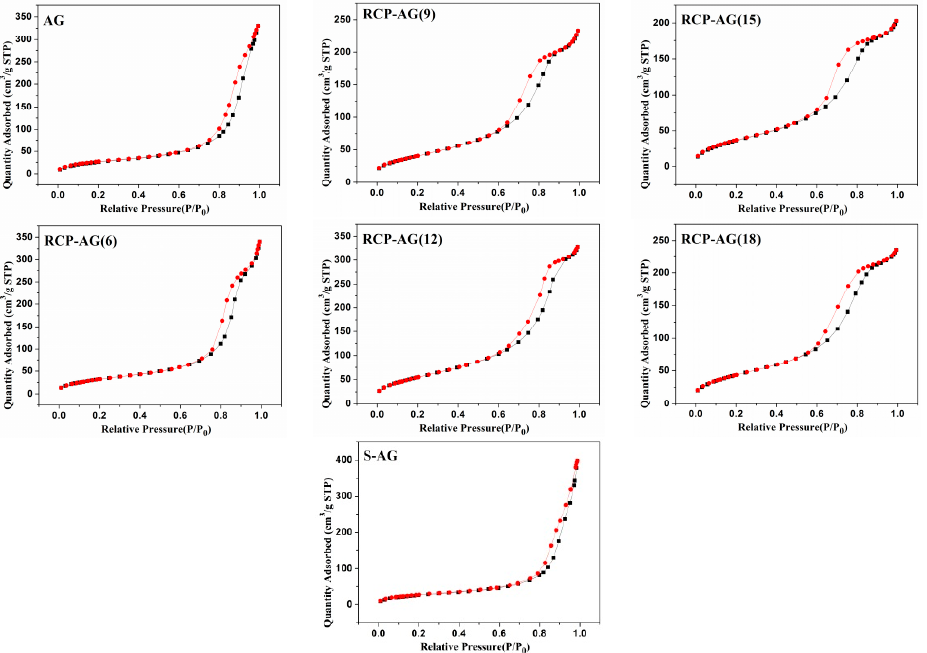
Figure 1. XRD patterns of the samples.